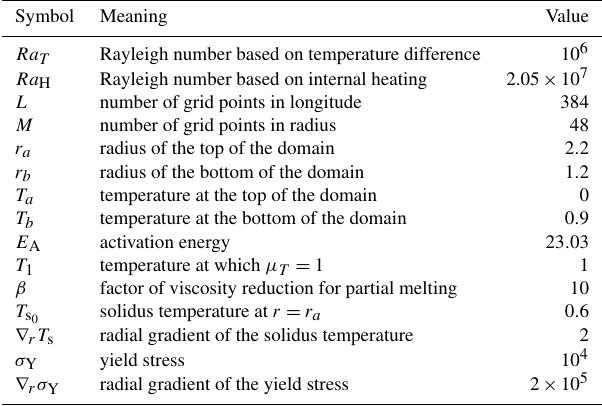
Table 1. Values of the parameters of the forward